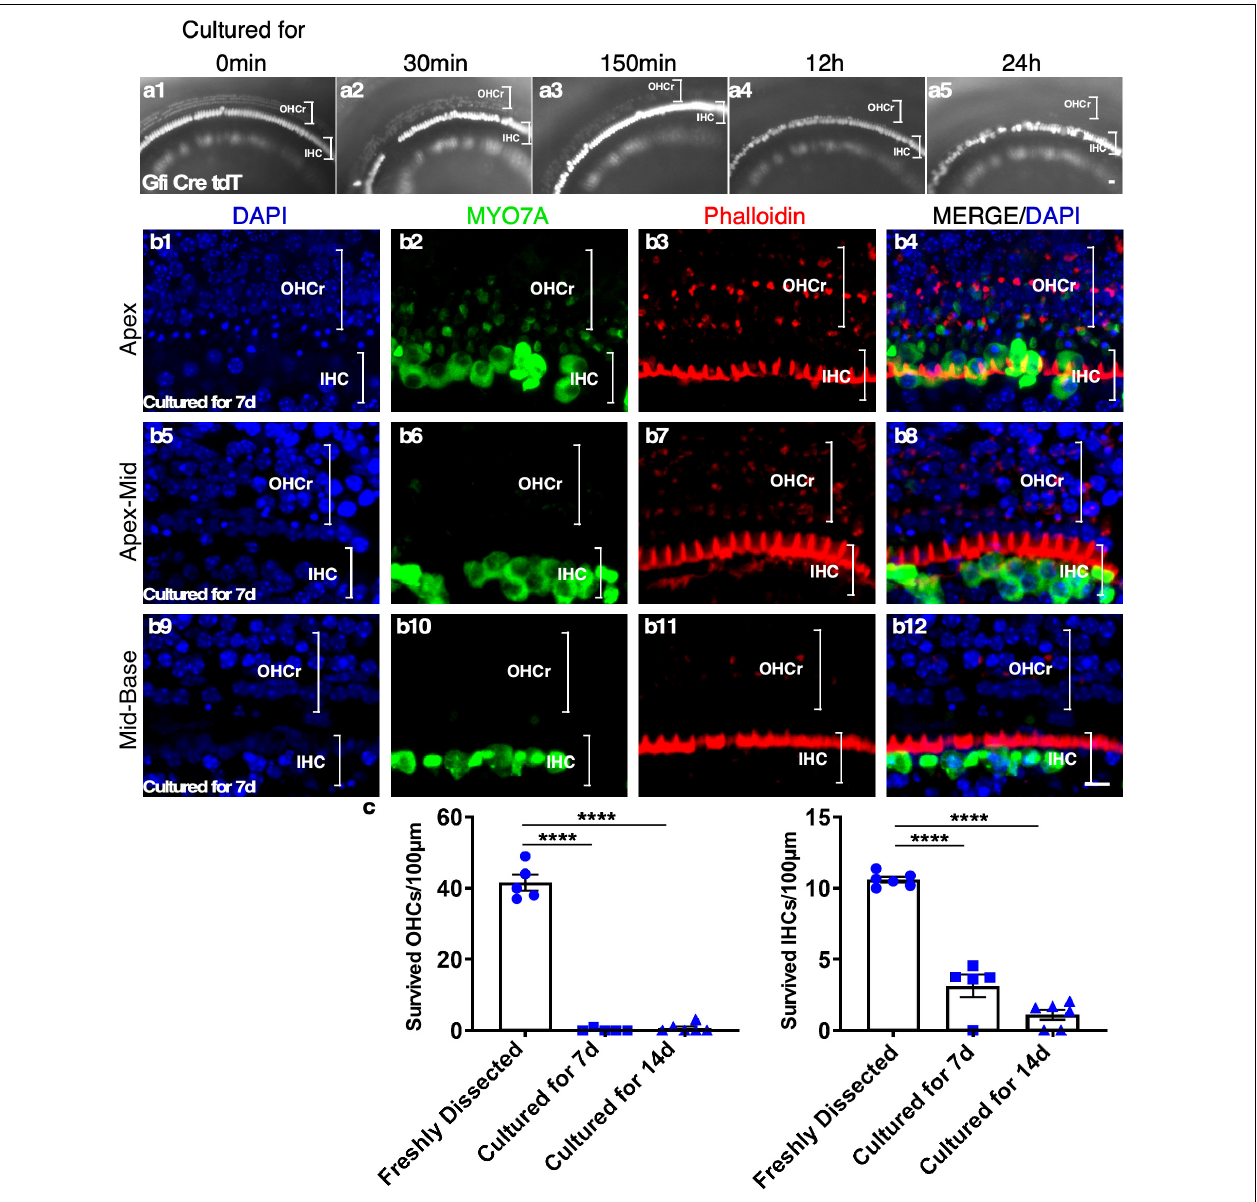
FIGURE 2 | The rapid loss of outer hair cells (OHCs) in adult cochlear culture. (a1–a5) The loss of OHCs in vitro . In adult Gfi-Cre-Tm-red cochlear culture (apex), the loss of OHCs (by the absence of the Tm-red signals) started as early as 30 min in culture (a2) . By 12 h (a4) , no OHC signal was detectable, an indication of complete OHC loss. In contrast, many inner HCs (IHCs) survived 7 days in culture (b1–b12) . (c) Quantification of surviving OHCs and IHCs from apex to base of the adult cochlear culture system. **** p < 0.0001, two-tailed unpaired Student’s t -test. Error bar, mean ± SEM, n = 5–6. n is the number of biologically independent cochlea samples. Scale bars: 10 µ